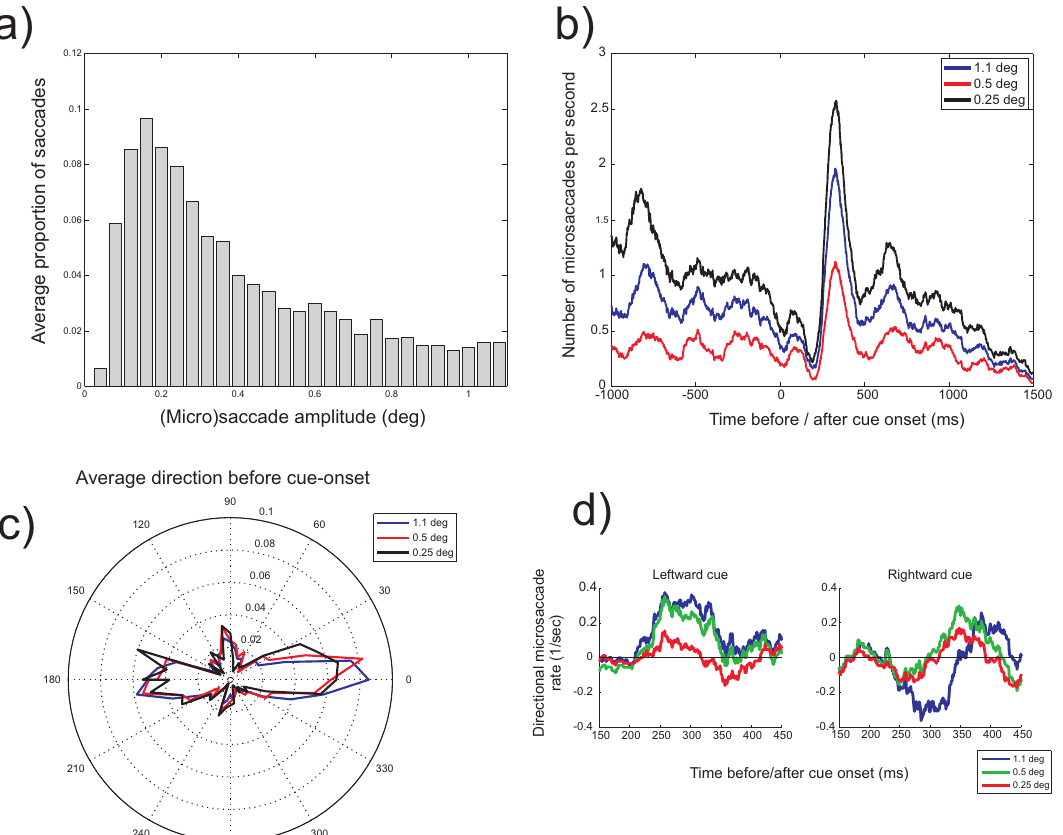
Figure 8 . a) Histogram of the amplitude of binocular saccades detected during visual fixation. b) Microsaccade rate (horizontal cue condition) as a function of the time before (negative values on the horizontal axis) and after cue onset (positive values) for three microsaccade amplitude thresholds (1.1deg, 0.5deg, 0.25deg). c) Histogram of microsaccade direction (horizontal cue condition) before cue onset for the three amplitude thresholds. d) Difference in the microsaccade leftward (+ve) and rightward (-ve) rates for leftward and rightward cues and for the three amplitude thresholds in the 150-450ms intveral after cue onset.